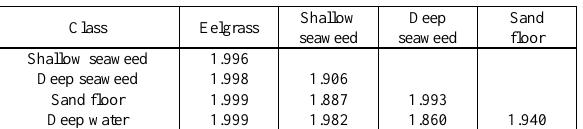
J–M distances computed with all the band reflectance of the UAV image of Souris